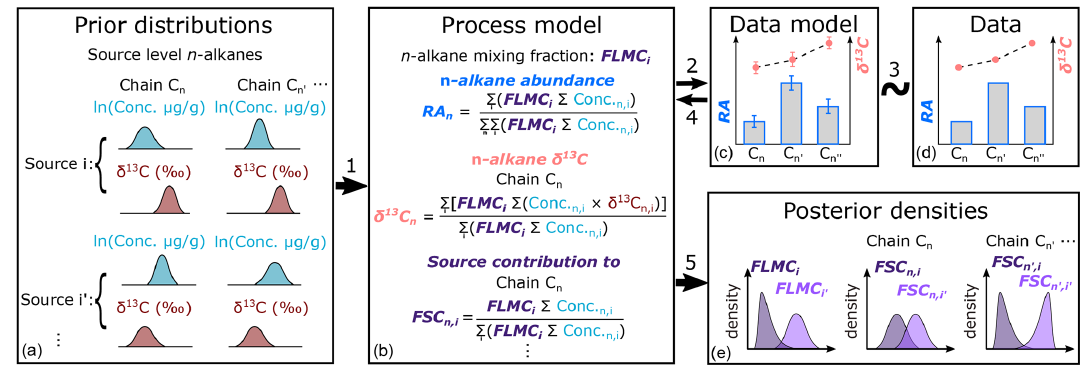
Figure 1. Proposed model structure of the Bayesian hierarchical framework for interpretation of n -alkane records, where model components are represented by boxes. Links between components are numbered and referenced in Sect. 2. RA stands for relative abundance of n -alkane chains. FLMC i is the fractional leaf mass contribution from source i . FSC n,i is the fractional contribution from source i to chain n